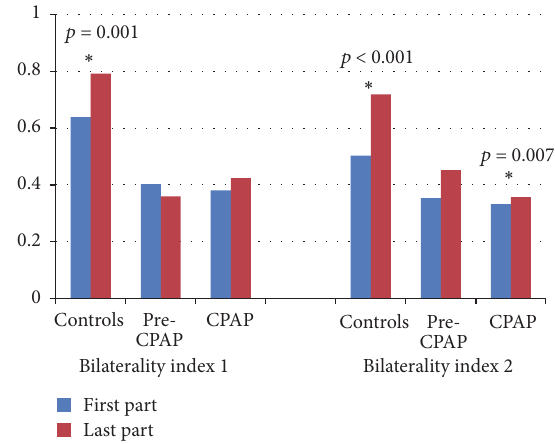
Figure 2: Bilaterality indices of the central spindles in the first and last part of the NREM sleep. The statistically significant differences are marked with an asterisk and denoted with the 𝑝